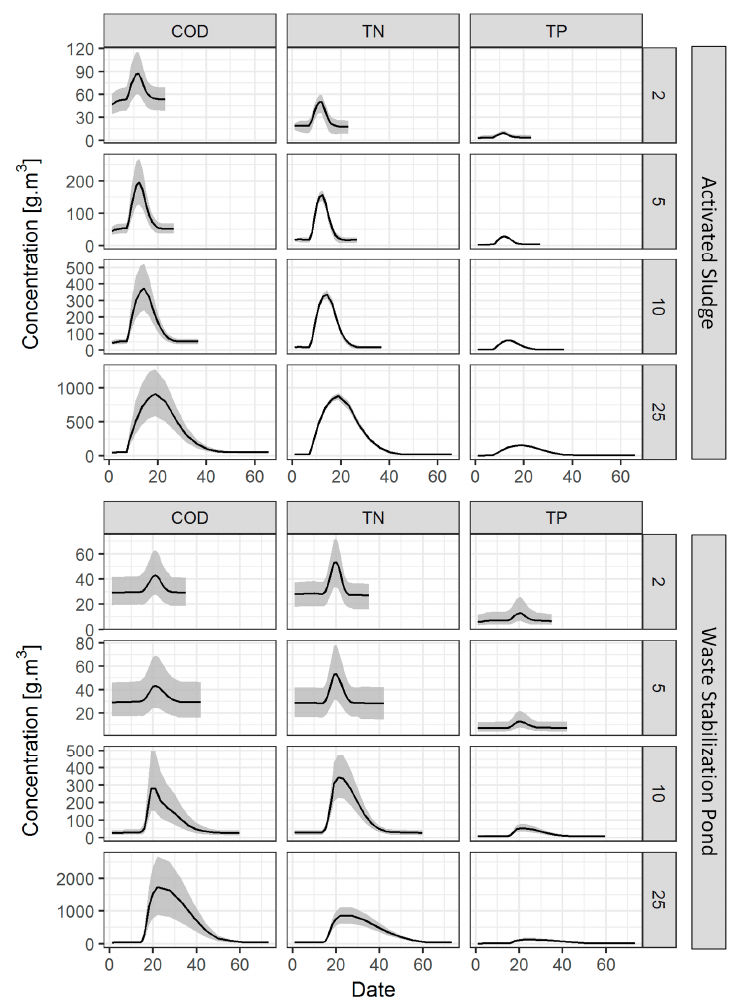
Figure 5. The performance of the activated sludge (AS) and waste stabilization pond (WSP) under four shock-load scenarios with different wastewater strengths, i.e., 2, 5, 10, and 25 times higher than the standard OECD domestic wastewater. The lines represent the mean value of the effluent concentrations regarding COD, TN, and TP. The grey bands represent the uncertainty range using 10th and 90th percentile values of the Monte Carlo simulations with all prior uncertainties.